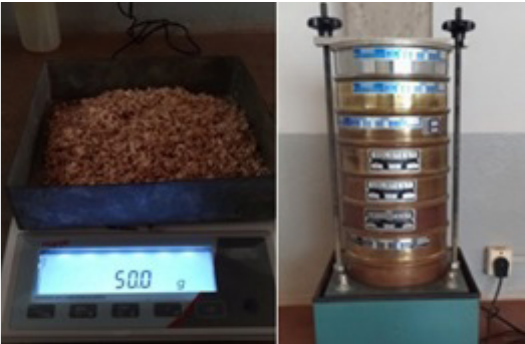
Figure 3. Particle size composition of wood